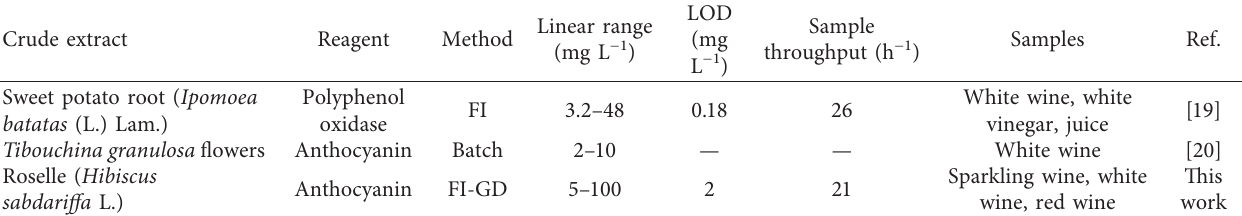
Table 1: The analytical performances of spectrometric determination of sulfite using various natural